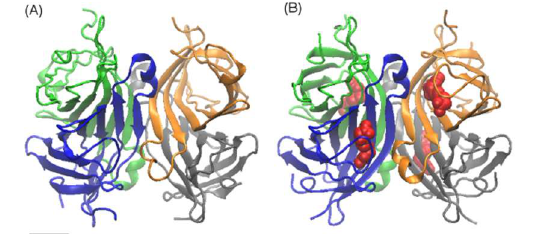
Fig. 1. This image shows the pdb structures of the ligand free STV tetramer (A), and of the complex STV+B (B), with one B per STV binding pocket [10]. Reprinted with permission from [10] M. Sarter et al., “Strong Adverse Contribution of Conformational Dynamics to Streptavidin-Biotin Binding,”